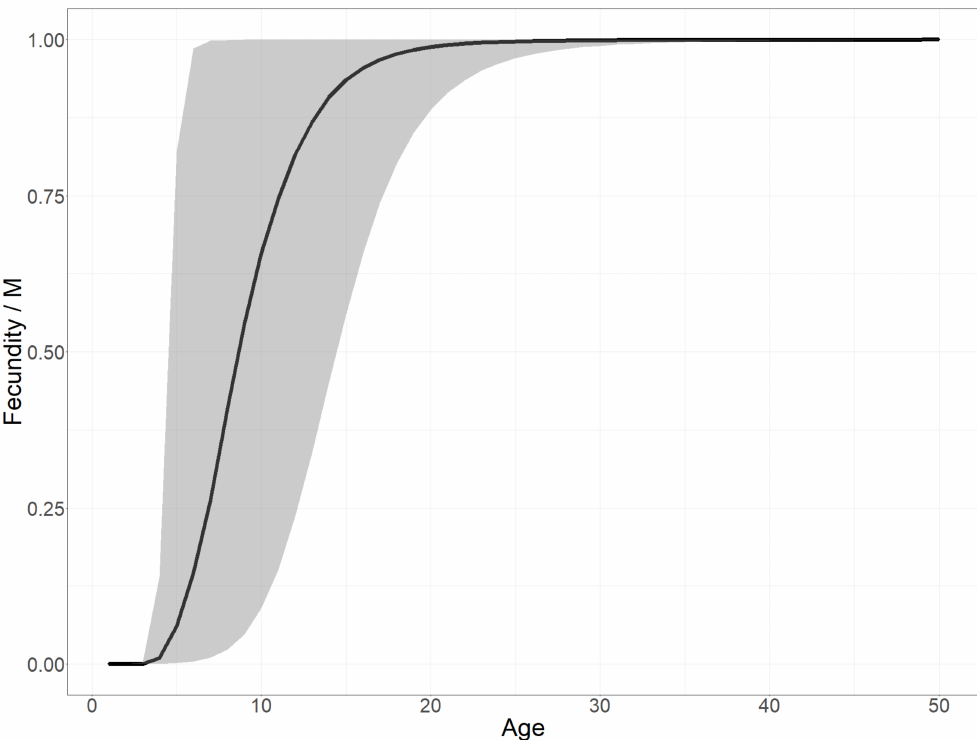
Figure 8. Posterior age-structured fecundity scaled by the maximal fecundity ( M ): mean posterior estimate (solid black line) and 95% confidence interval (gray ribbon). We first computed the curve from the three fecundity parameters (ˆ k , θ , M for each posterior sample and then calculated the mean and quantile values (2.5% and 97.5%) per